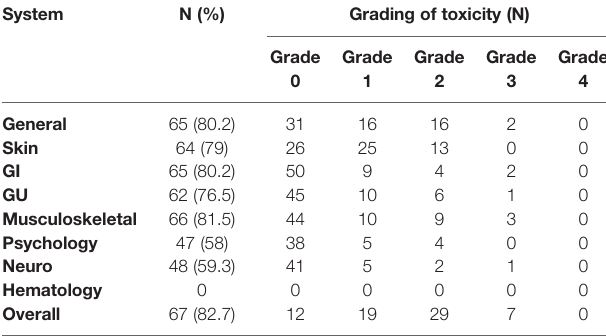
TABLE 4 | Late toxicity report for all